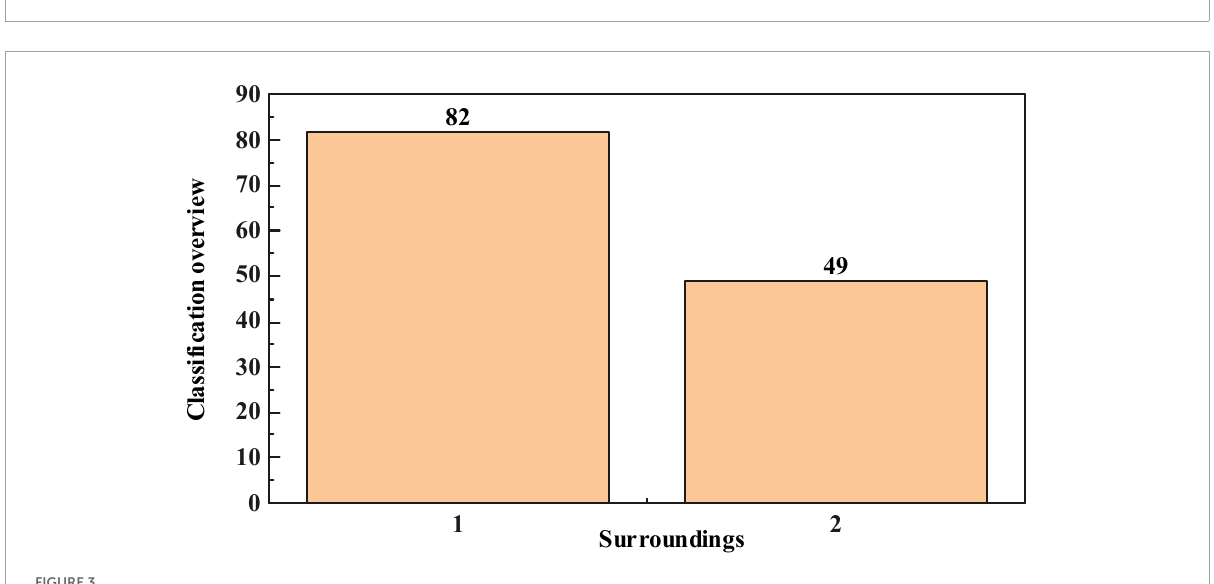
FIGURE2 Overview of gender classification of college students from divorced families.